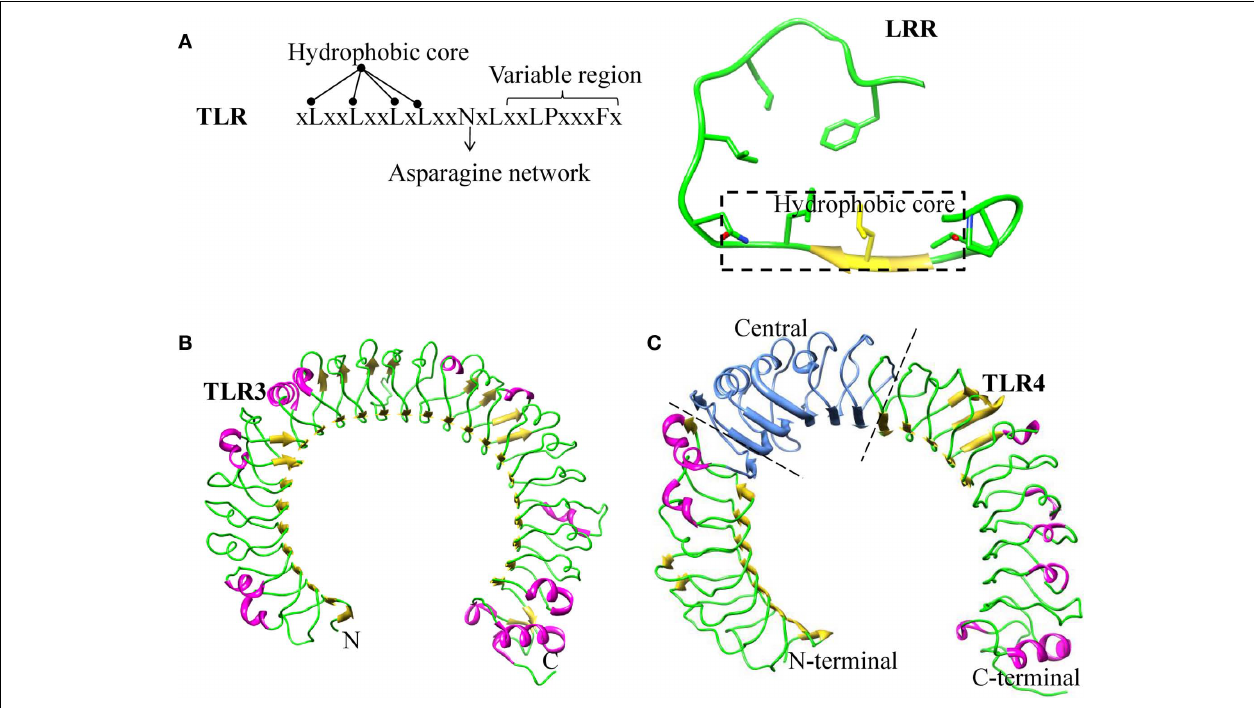
of the LRR forming the convex surface. (B) Ribbon diagram ofTLR3–ECD: LRR domain has uniform β sheet angles and a continuous asparagine network. (C) Ribbon diagram ofTLR4 ECD showing the position of three sub domains: N-terminal, Central, and